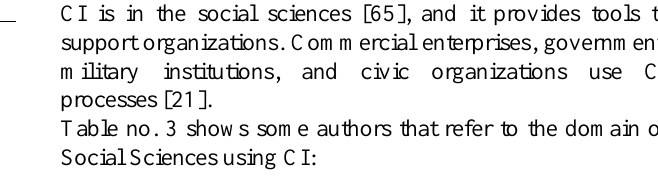
Table 3. Domain Social Sciences using